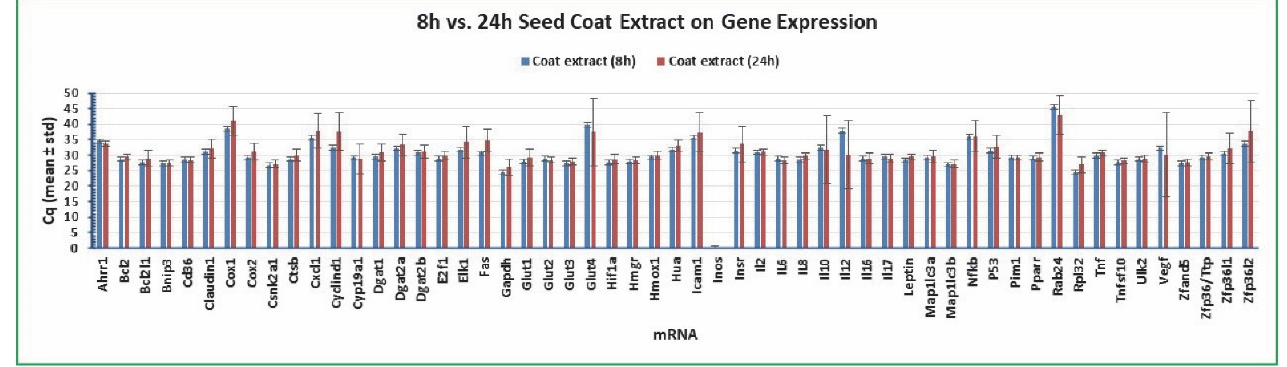
Figure 7. Variation of gene expression between 8 and 24 h treatment of coat extract of cottonseed. The cancer cells were treated with multiple concentrations of cottonseed extracts (0, 5, 10, 20, 30, 40, 50, and 100 µg/mL) for 8 h. Total mRNAs were extracted from the cells, converted into cDNAs, and the relative abundance was analyzed by SYBR Green qPCR. The Cq values represented the mean and standard deviation of 48 independent samples.